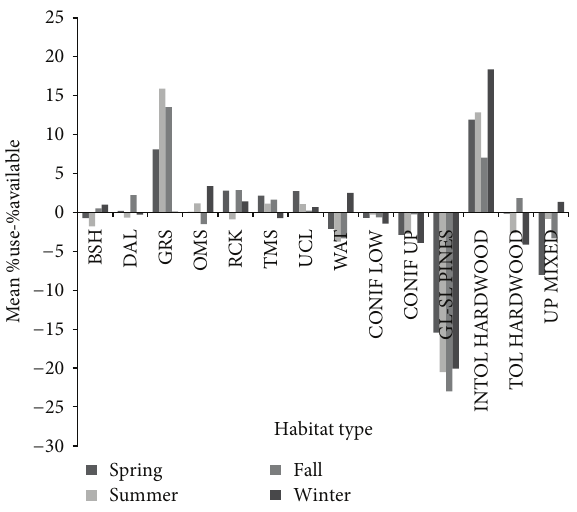
Figure 3: The mean differences between % use and % available for each habitat type in different